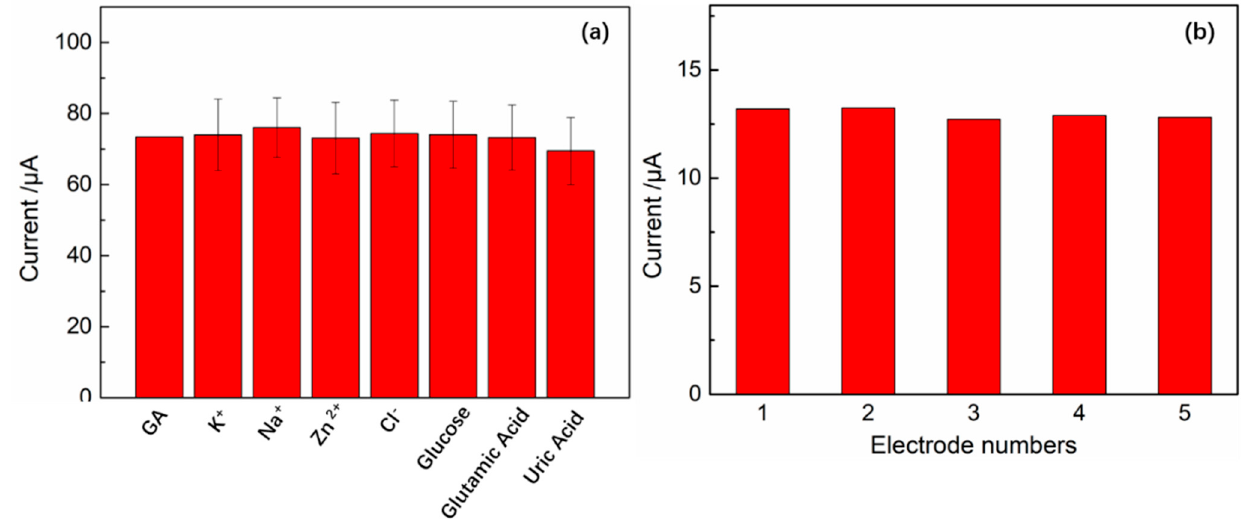
Figure 9. Selectivity of Co-MOF/CNTs/SiO 2 /AuE ( a ); Reproducibility of Co-MOF/CNTs/SiO 2 /AuE for GA ( b ).